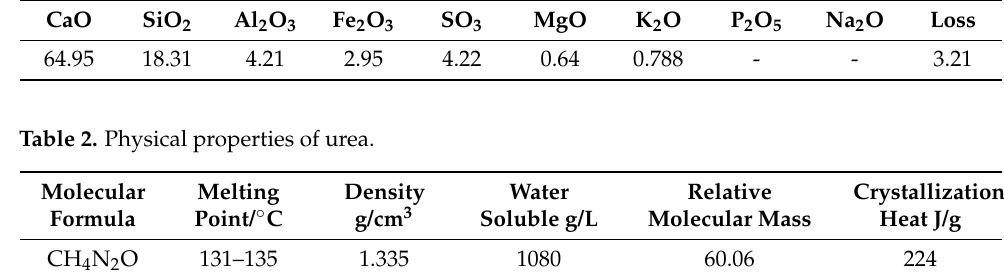
Table 1. Chemical compositions of cement/wt%.